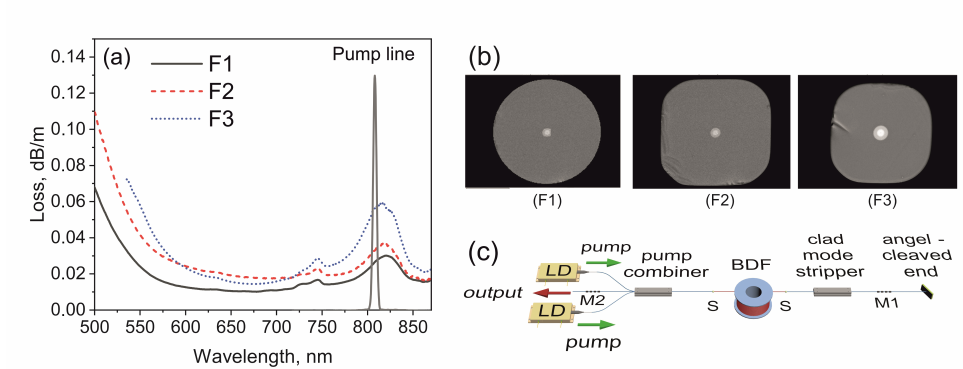
Figure 1. ( a ) The clad absorption spectra of the studied fibers. ( b ) Electronic microscope images of the cross-sections of F1, F2 and F3 fibers. ( c ) Laser construction based on the tested BDFs, where S indicates a splice of an active fiber with a conventional passive fiber, M1 and M2 are the mirrors used and LD is a multi-mode laser